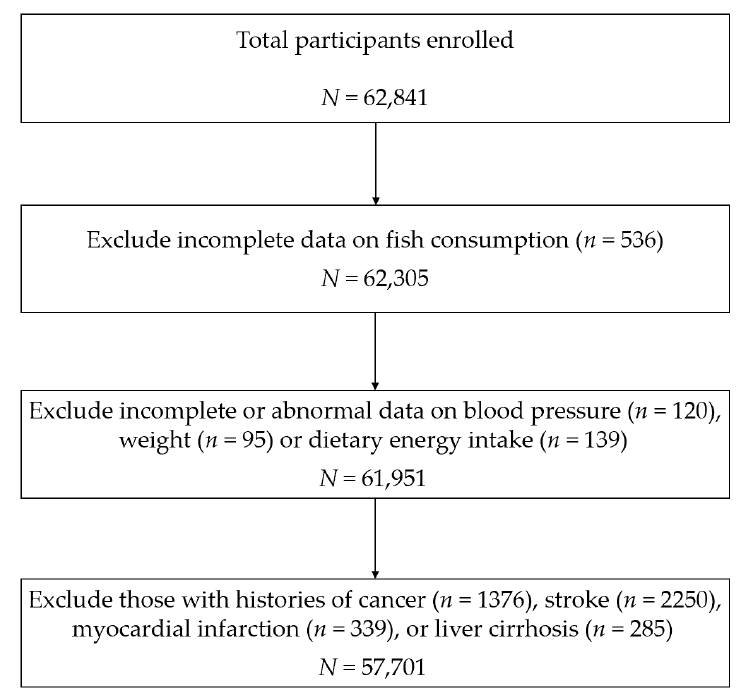
Figure 1. Flow of the participant screening.